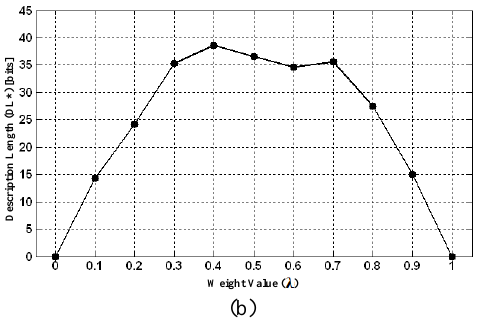
Figure 7. Optimal weight value ( ) before (a) and after (b) the normalization of two regularization terms.